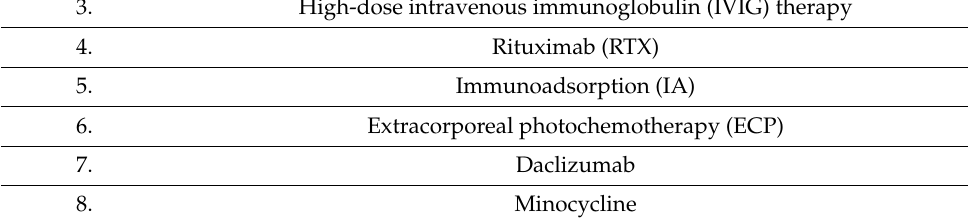
Table 1. EBA’s current treatment options.